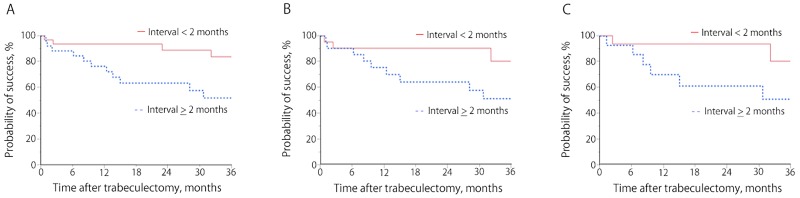
Kaplan–Meier survival curves for each of the three failure criteria in the second operated eye, comparing patients for whom the interval between trabeculectomies was ≥2 months with those for whom the interval was <2 months.Criterion A: intraocular pressure (IOP) >21 mmHg, <20% reduction of preoperative IOP, reoperation for glaucoma, a loss of light perception vision, or hypotony of ≤5 mmHg. Criterion B: IOP >18 mmHg, <20% reduction of preoperative IOP, reoperation for glaucoma, a loss of light perception vision, or hypotony of ≤5 mmHg. Criterion C: IOP >15 mmHg, <20% reduction of preoperative IOP, reoperation for glaucoma, a loss of light perception vision, or hypotony of ≤5 mmHg. The cumulative success rates for intervals between trabeculectomies of ≥2 months and <2 months were 52.0% and 83.6% for Criterion A (P = 0.0031), 51.5% and 80.4% for Criterion B (P = 0.026), and 51.1% and 80.4% for Criterion C (P = 0.048).